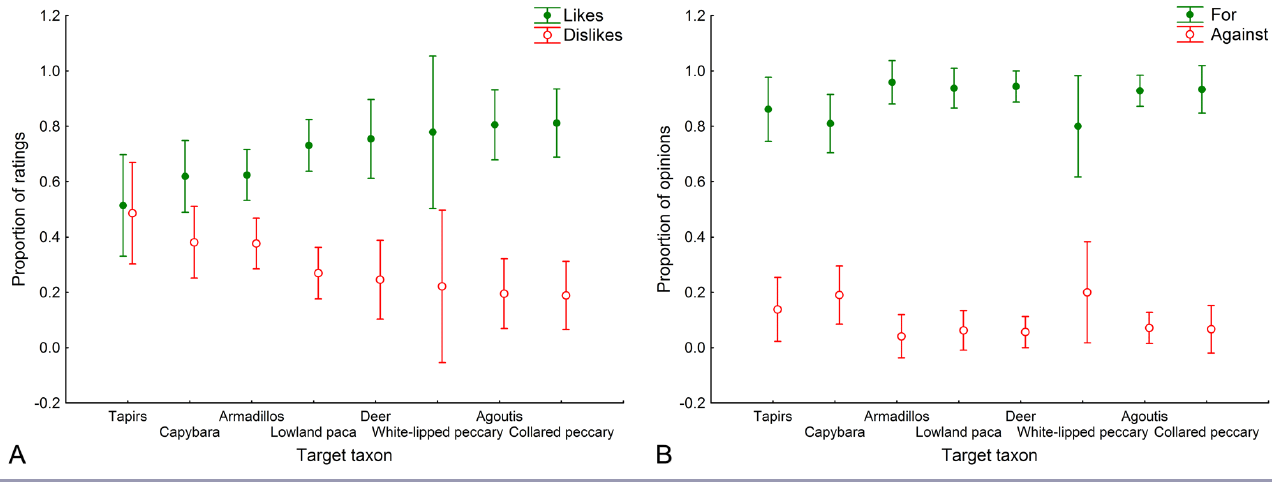
Fig. 6 . Comparison of A: the means of proportions of likes and dislikes offered by internet users to hunting videos of the eight main mammalian taxa hunted in Brazil; and B: the means of proportions of comments for and against sport hunting in Brazil. For scientific names of species, see Table 1.